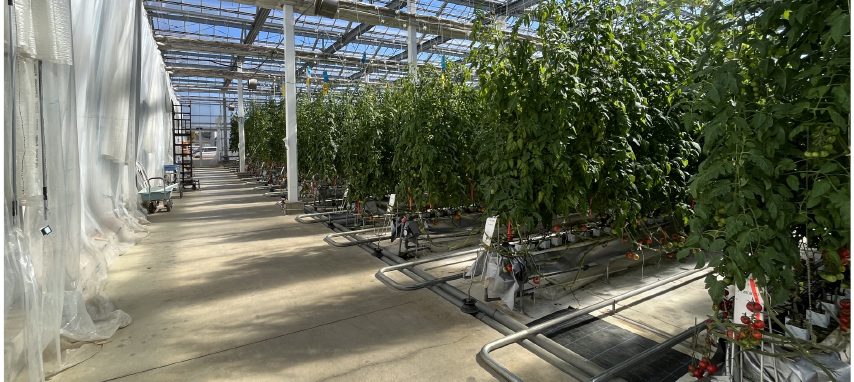
Figure 1. Our greenhouse environment. Hot water pipes are installed between two rows of tomato plants. The tomato plants are guided to different